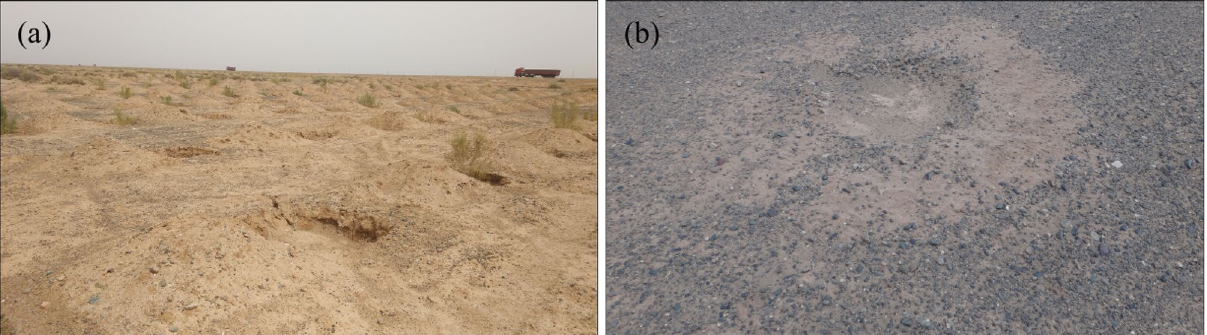
Figure 7. Surface of gobi region in Ejina after pits for shrubs were dug by excavation ( a ) and auger digging ( b ).